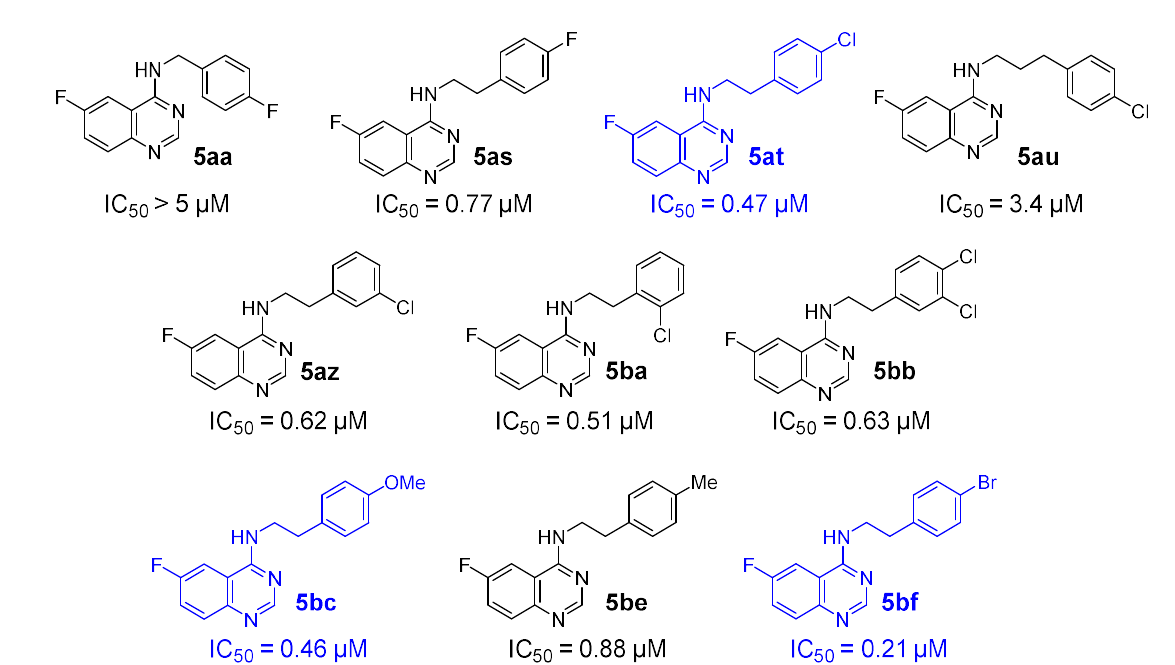
Figure 10. IC 50 values of promising analogues with Spautin-1 as reference (most active compounds (IC 50 < 0.5 µM) highlighted in blue).